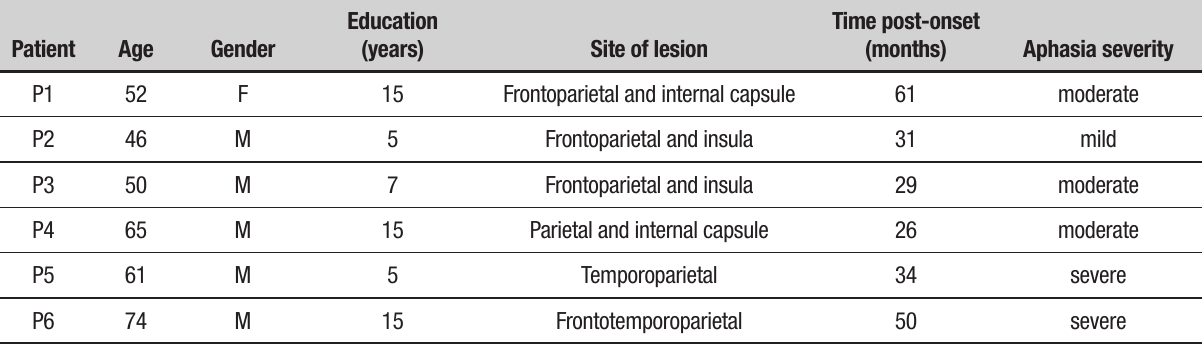
Table 1. Demographic and clinical characteristics of the